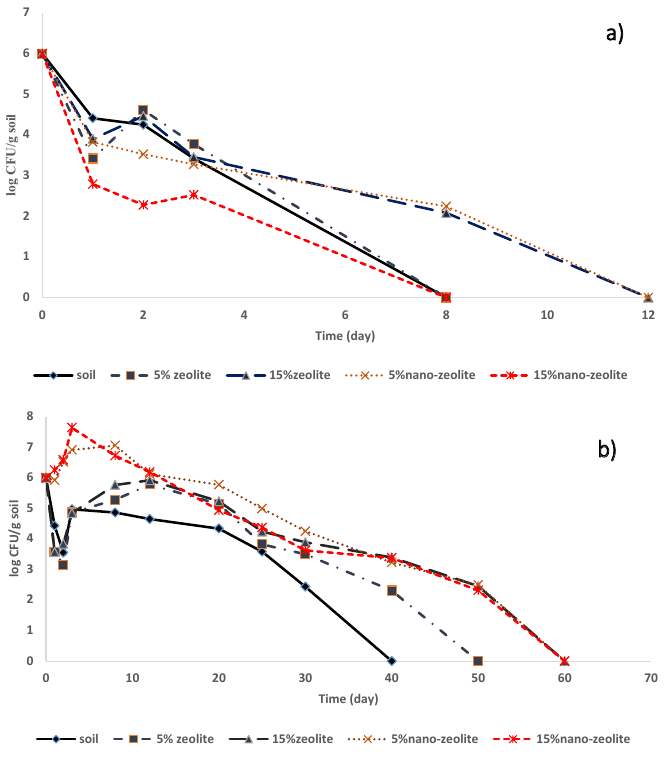
Figure 3: Changes in culturable E. coli NAR over time in unsterile (a) and sterile (b) mixtures.